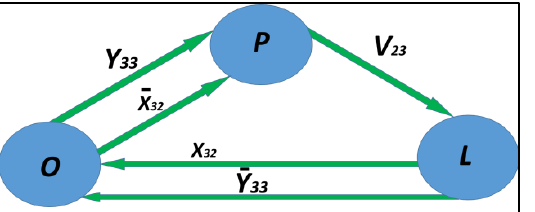
Figure 11. Automatic graph of the valve 23 in the milk chilling mode.